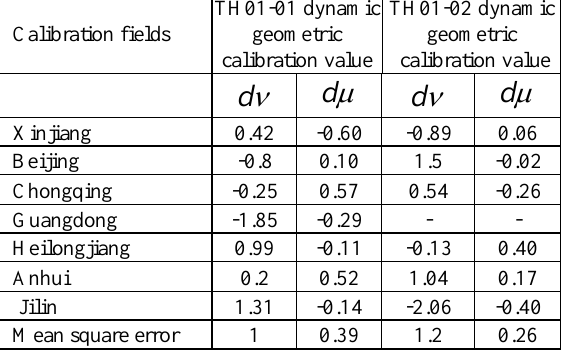
Table 8 Result of dynamic geometric calibration of TH01-01 and TH01-02 satellite （  d ： low frequency error of picth